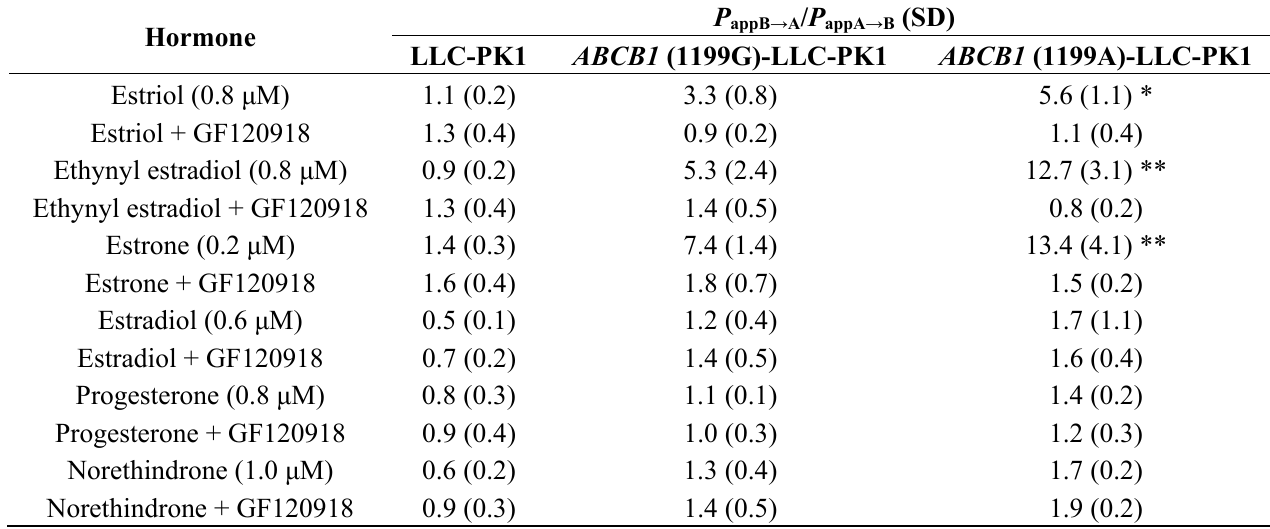
Figure 4 . Transepithelial transport of 0.8 μ M estriol across monolayers of LLC-PK1 cells expressing the ABCB1 (1199G) or ABCB1 (1199A) allele. Untransfected LLC-PK 1 cells served as a control. Estriol was added to the basolateral or apical chamber, and the medium in the opposite chamber was sampled at 0.5, 1.0, 1.5, and 2 h. Data shown are mean ± SD of three replicates. Table 2. Transepithelial permeability of untransfected LLC-PK1 cells and LLC-PK1 cells expressing the ABCB1 (1199G) or ABCB1 (1199A) allele to hormones in the presence or absence of P-gp inhibitor